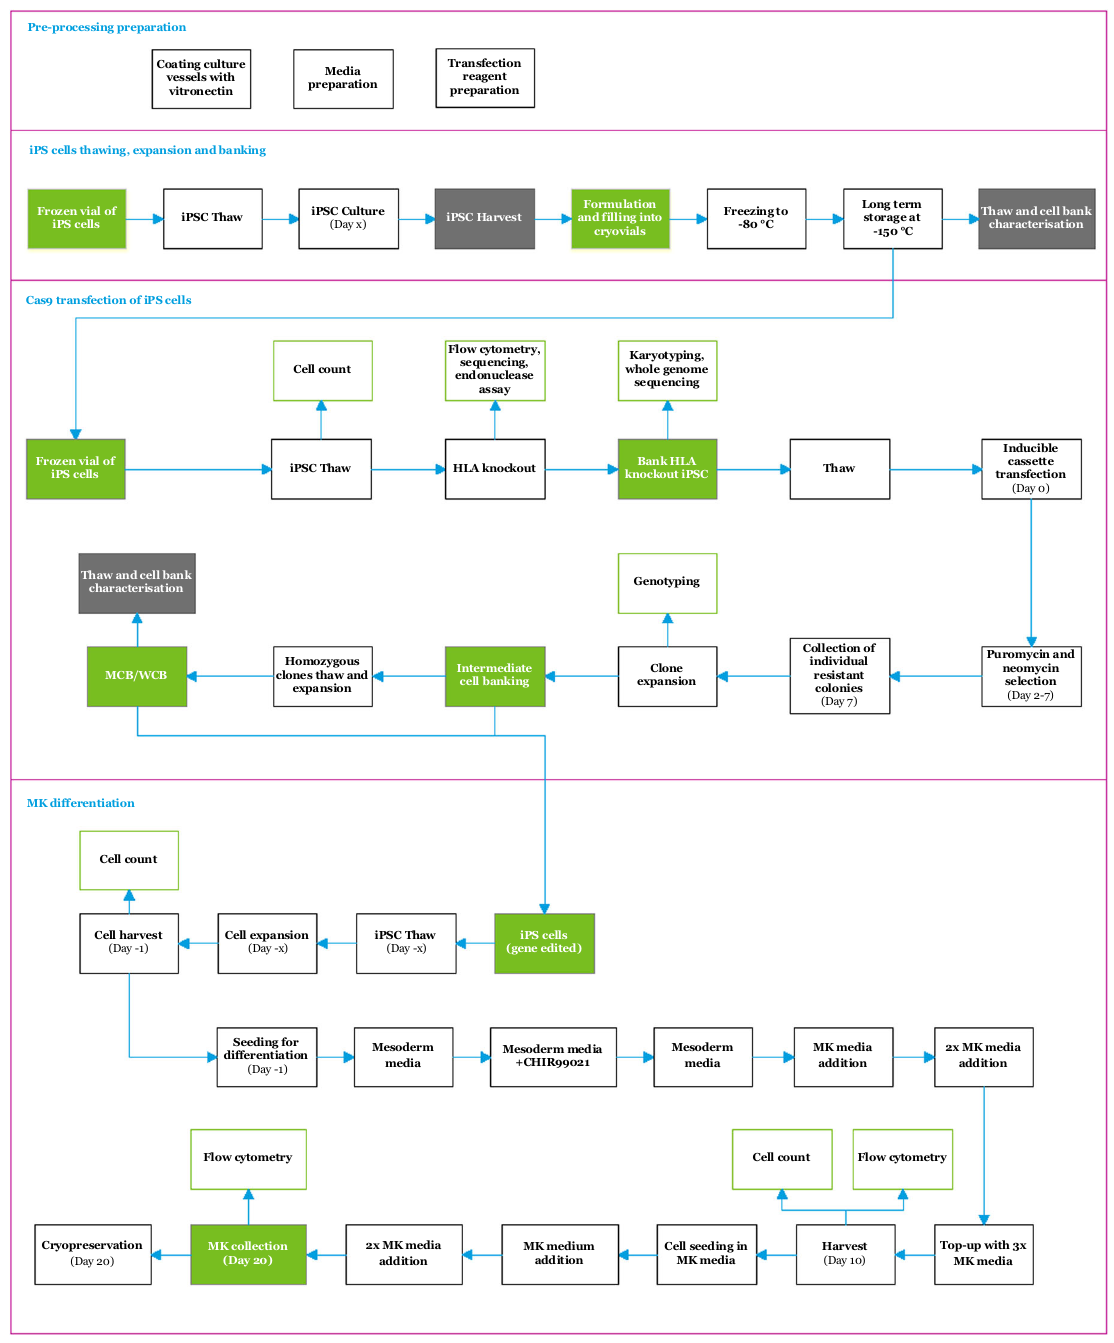
Fig. 2 Process fl ow diagram of the megakaryocyte forward programming protocol. The days of the protocol on which each step takes place are